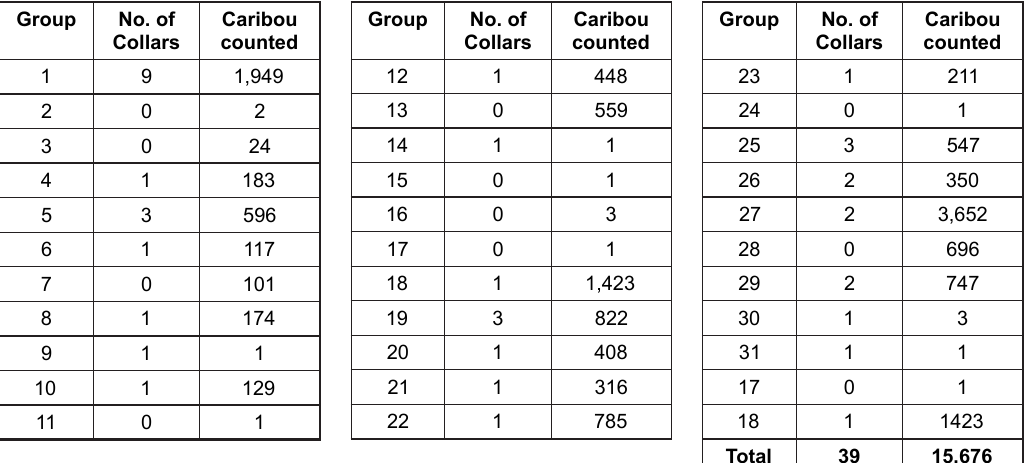
Table 16. Caribou groups counted for the 2012 Bluenose-West survey.